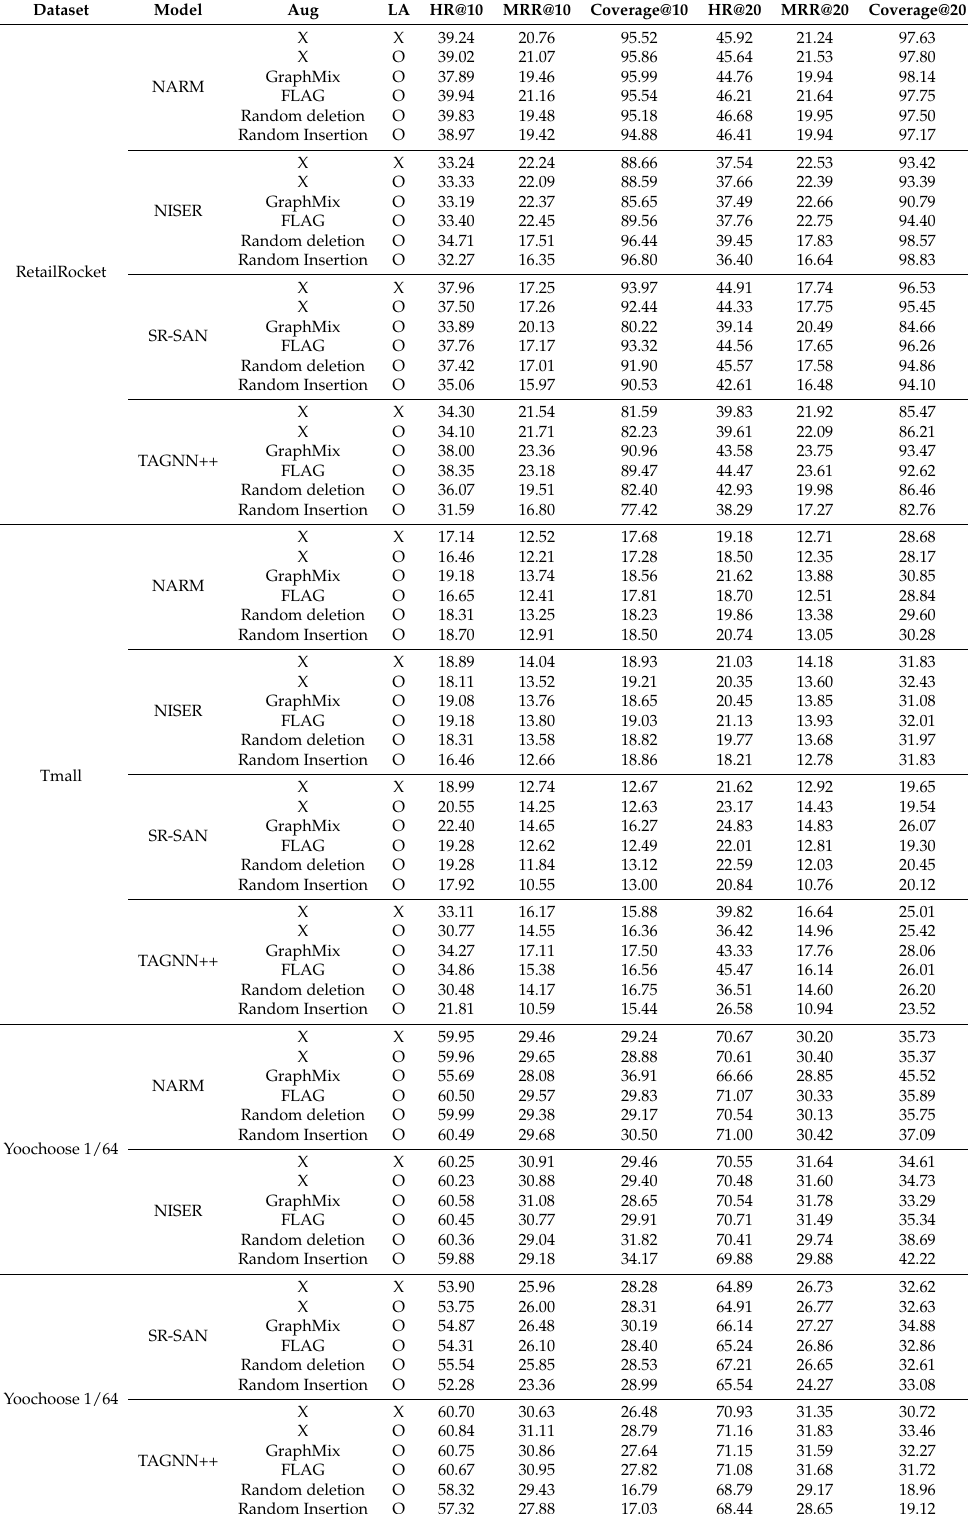
Table A1. The result of different data augmentation methods in four different models. In column LA, we mark ’X’ to indicate the baseline without using LA and mark ’O’ to indicate the baseline with using